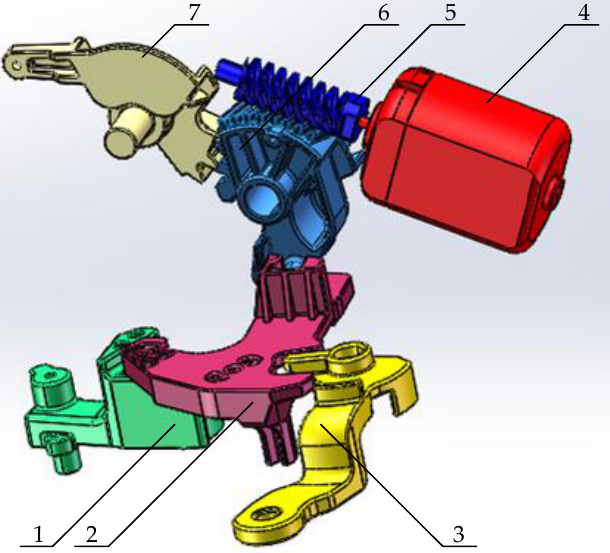
Figure 4. The locking mechanism model. (1) Pawl connect arm, (2) locking connect arm, (3) key locking toggle arm, (4) motor, (5) worm, (6) locking gear, (7) inside locking toggle arm.